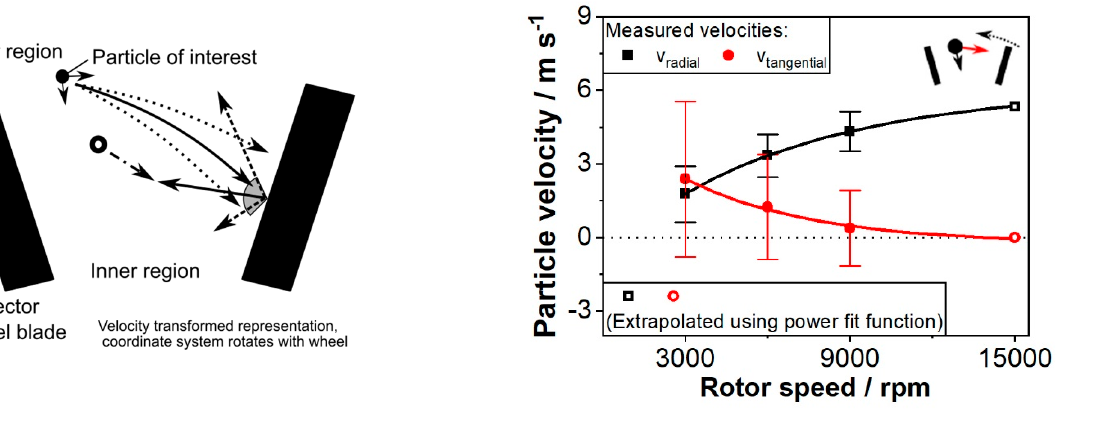
Figure 6. ( Left ) Schematic overview of the particle movement between deflector wheel paddles. A co-rotating representation with the classifier wheel rotating counterclockwise. Interrupted lines represent different alternative trajectories. Collision patterns are more detailed in Section 4.4. ( Right ) Particle motion of limestone particles before impacting on the classifier wheel in a stationary reference frame. For 15,000 rpm, the indicated extrapolated values were used. As indicated in the inlay in the top right corner, positive radial velocities indicate inbound motion (black arrow), while positive tangential velocities indicate clockwise motion (red arrow). The sense of rotation of the deflector wheel is indicated by the dotted black arrow.